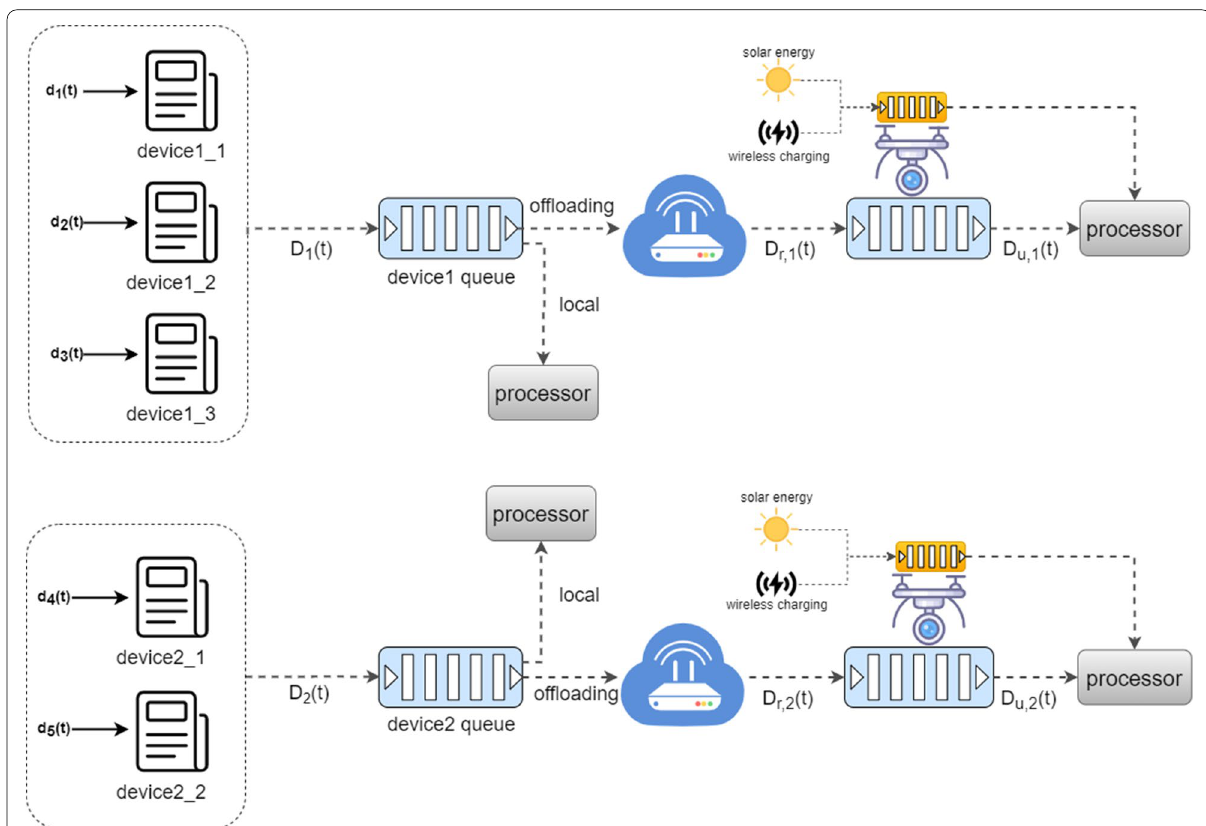
Fig. 1 Basic scenario of UAV-assisted